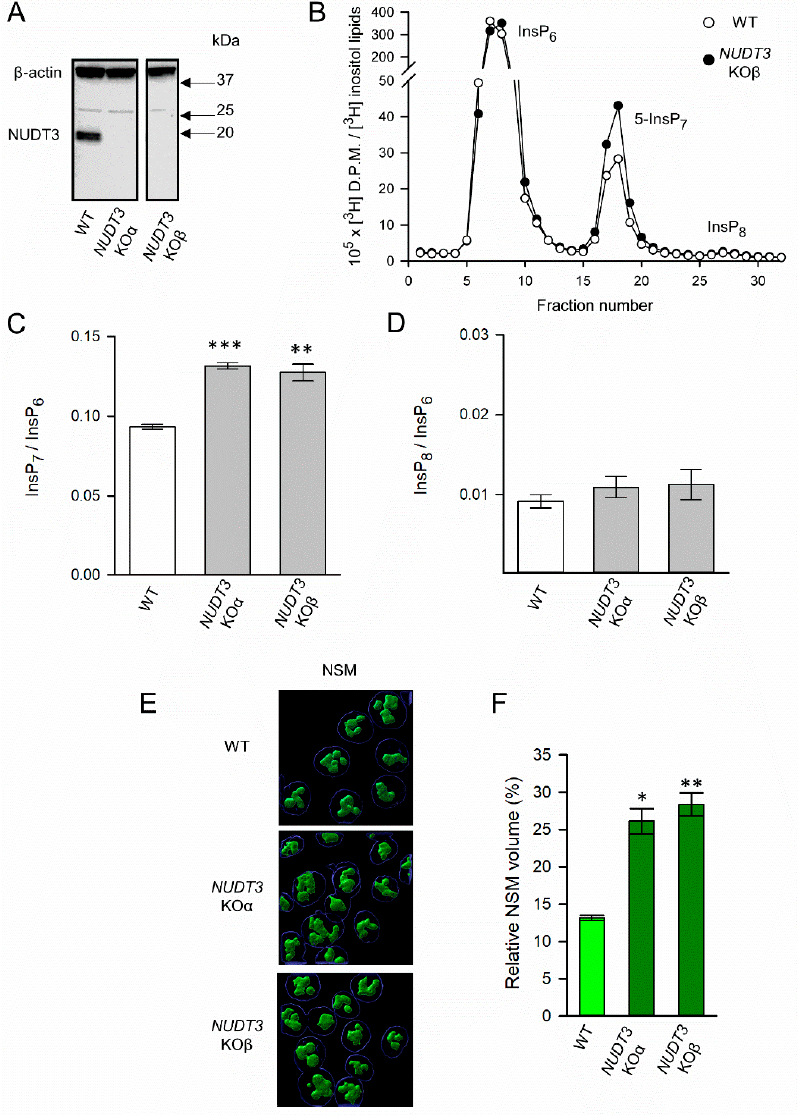
Figure 4. The effects of NUDT3 KO upon PP-IP levels and NSM volume in HCT116 cells. ( A ) Western analysis of NUDT3 protein expression in WT HCT116 cells and two independent clones of NUDT3 KO cells (KO α and KO β ). All lanes are from a single gel, from which non-relevant lanes have been removed. ( B ) HPLC resolution of [ 3 H]-labeled InsP 6 , InsP 7, and InsP 8 from [ 3 H]-inositol radiolabeled wild type (open circles) and NUDT3 KO β (closed circles) HCT116 cells . ( C ) Cellular 5- InsP 7 levels in WT (white bars) and NUDT3 KO α and KO β lines (gray bars). Data are means ± standard errors from four experiments. ( D ) Cellular 5-InsP 8 levels in WT and NUDT3 KO α and KO β lines. Data are means ± standard errors from four experiments. ( E ) Representative three-dimensional rendering of Z-stack images of NSM volume in WT and NUDT3 KO α and KO β lines. ( F ) The bar graphs represent means and standard errors from three independent Z-stack datasets (10 fields of view per condition, each containing at least six nuclei). Scale bars (in yellow) depict five µm. *** p < 0.001, ** p < 0.01 * p < 0.02.